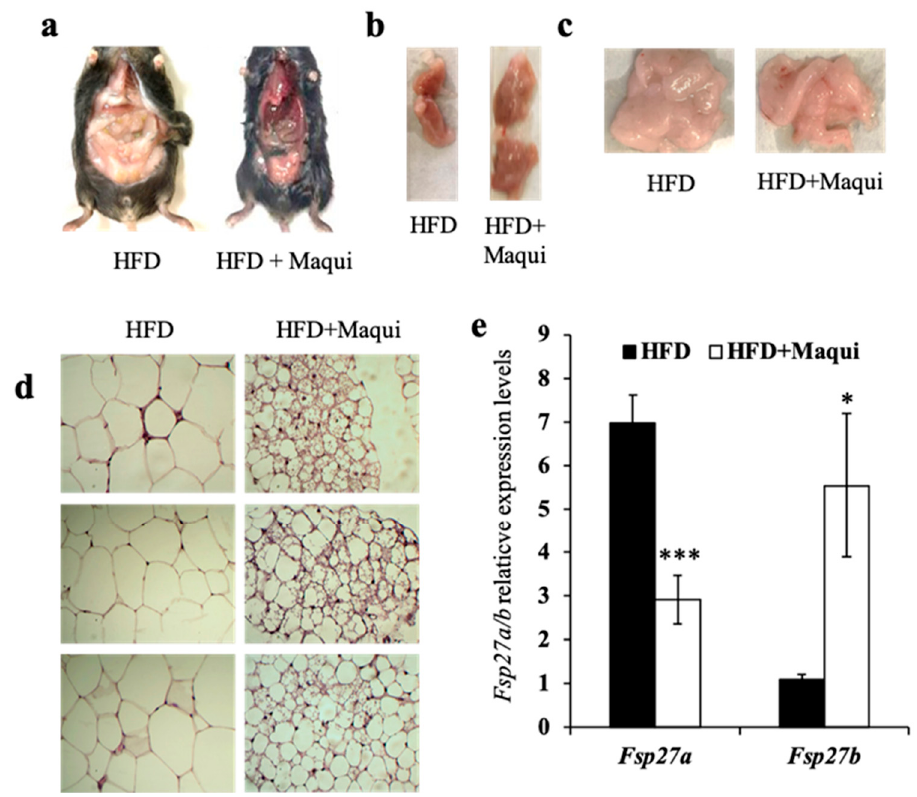
Figure 2. Maqui dietary supplementation induces a multilocular phenotype in scWAT. ( a ) Representative pictures of HFD ( n = 9) and HFDM ( n = 14) mice after 16 weeks of nutritional intervention. HFDM mice are leaner and show fewer white fat depots. ( b ) Representative pictures of interscapulum BAT of HFD and HFDM mice. For HFDM mice, the BAT depot is larger than the one from HFD mice. ( c ) Representative pictures showing scWAT depots of HFD and HFDM mice. ( d ) Representative hematoxylin and eosin (H&E)-stained scWAT sections from HFD and HFDM (40 × magnification). Some multilocular adipocytes are revealed in scWAT of HFDM, but none were seen in the HFD animals. ( e ) Fsp27a and Fsp27b mRNA levels were measured by qRT-PCR in scWAT of HFD and HFDM mice. Bars represent the relative mRNA levels of both genes in the two experimental conditions in scWAT normalized by the B2M gene as housekeeping gene. Data are presented as the mean ± SEM. * p < 0.05, *** p < 0.001 versus the HFD group.